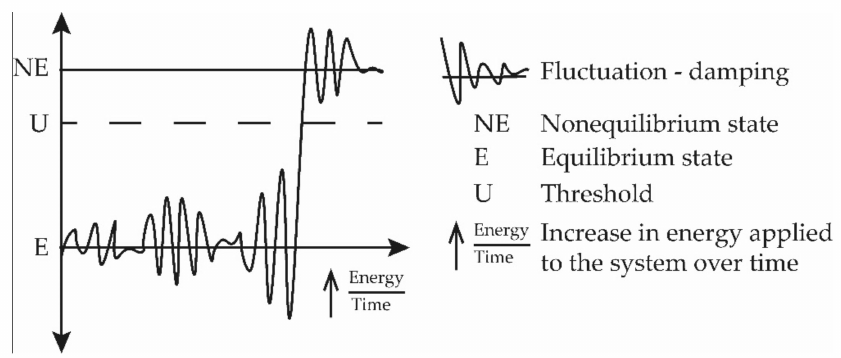
Figure 1. Dynamics of dissipative structures